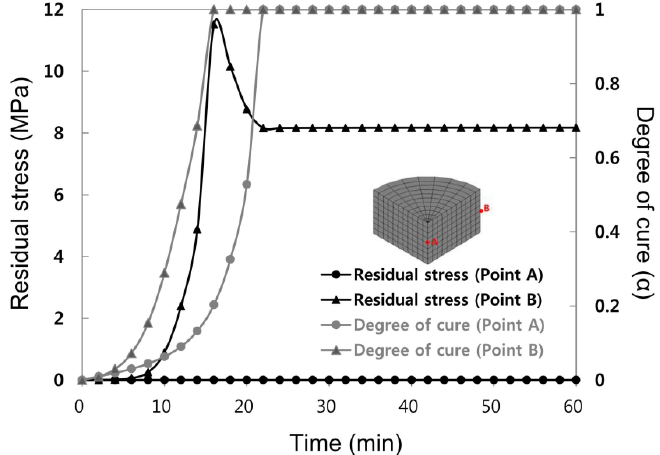
Figure 6. Residual Stress evolution and degree of cure during the two-step curing at Points A and B.